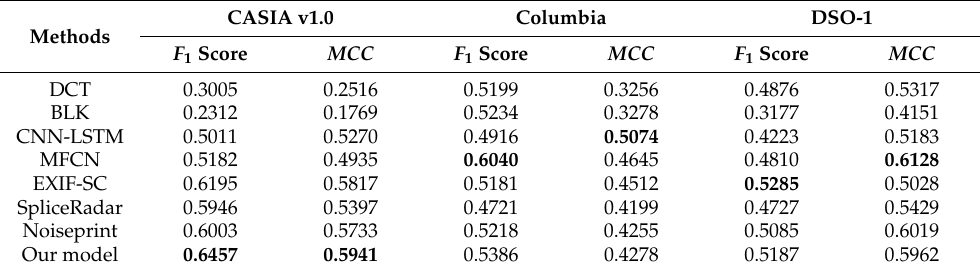
Table 2. The average F 1 scores and MCC metric of all methods on three test datasets.